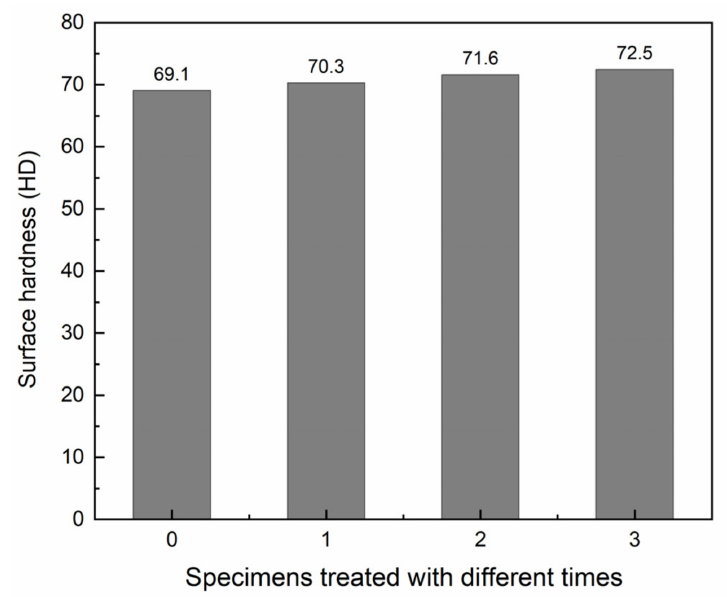
Figure 14. Surface hardness of the specimens before and after